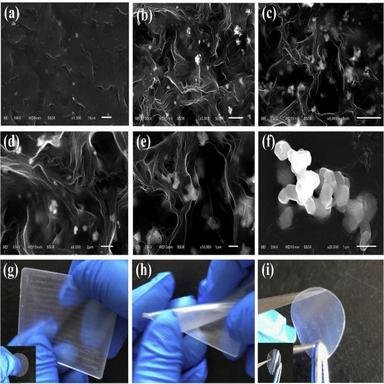
(a–f) the SEM of LBF05@PEO solid composite electrolyte (PEO:F = 10) at different multiplying rates; (g–i) the photos of solid-state composite electrolyte membranes.